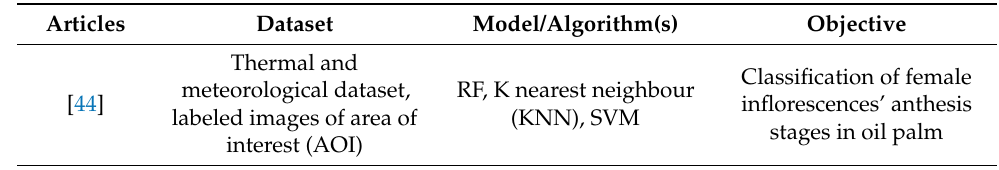
Table 2. Multipurpose